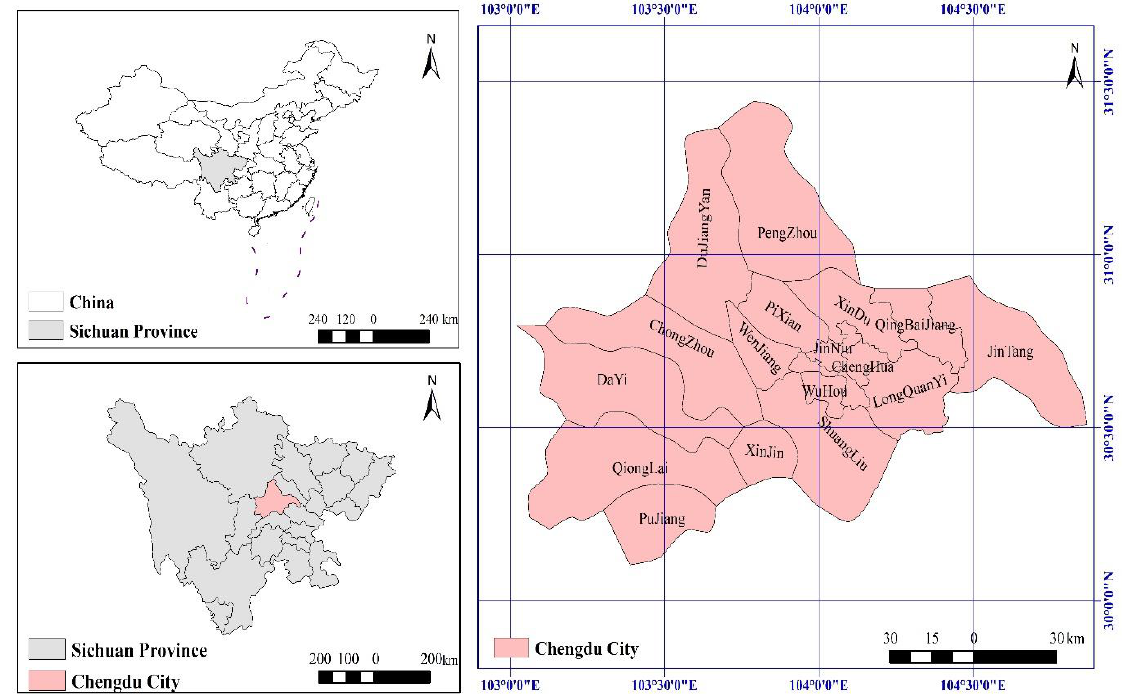
Figure 1. County map of Chengdu.